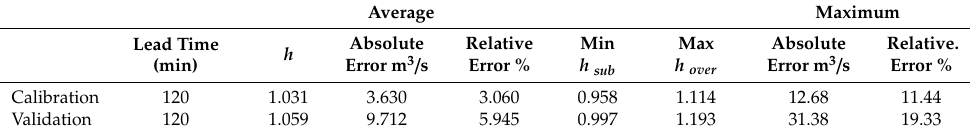
Figure 11. ( a ) Flow forecasts vs measured flows at the Graus station. ( b ) Empirical frequency distribution of the errors (validation data set).